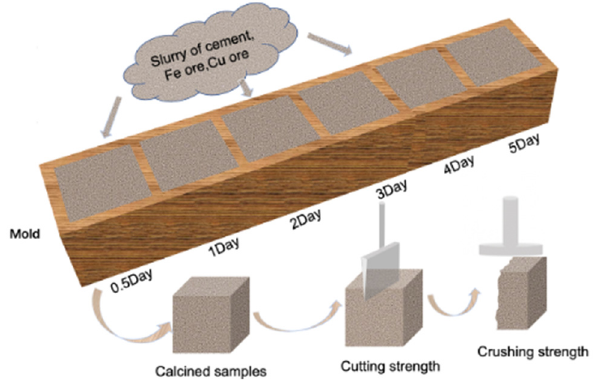
Figure 3. Preparation of cubic cement-bonded samples and cutting and crushing strength tests of the calcined samples with varying aging durations (0.5 day, 1 day, 2 days, 3 days, 4 days, and 5 days).